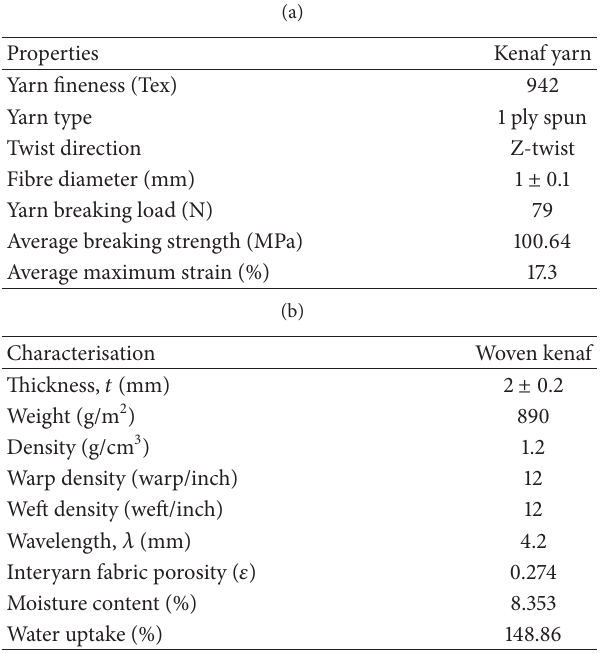
Table 2: (a) Properties of kenaf yarns. (b) Properties of plain weave kenaf fabric.